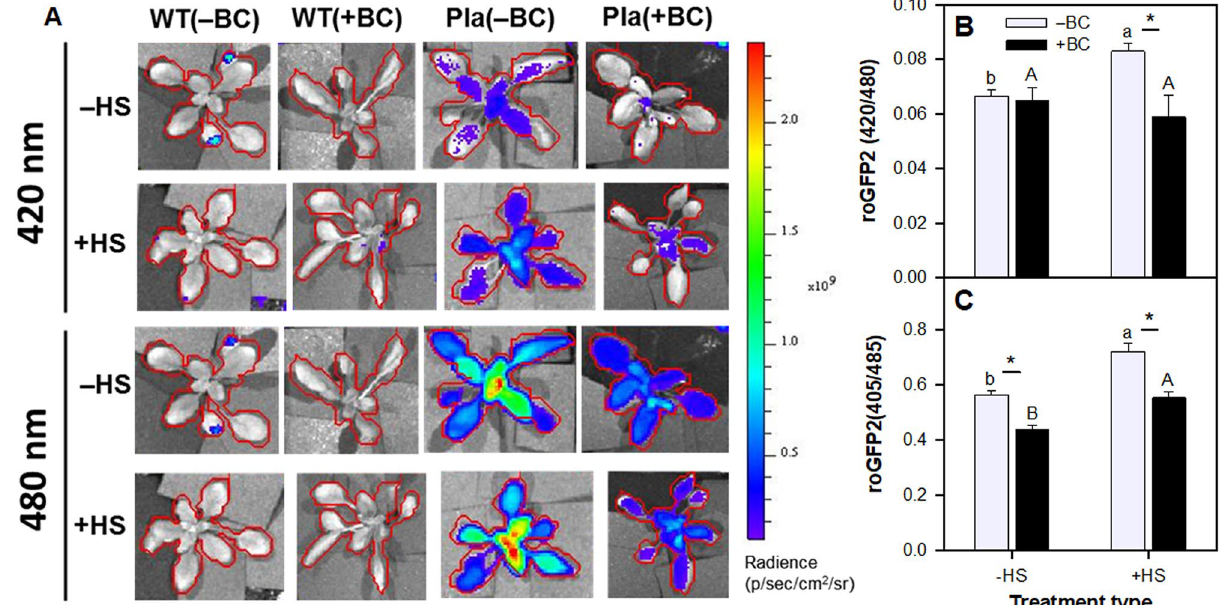
Figure 3. Effect of absence ( ‒ BC) and presence (+ BC) of biochar on the redox level of wild type (WT) plants and Arabidopsis thaliana expressing roGFP2 in the plastids (pla-roGFP2) under ‒ HS and + HS conditions at 21 days. ( A ) In-vivo qualitative depiction of whole WT and roGFP2 plants excited at 420 nm (oxidation) and 480 nm (reduction); ( B ) In-vivo redox (oxidized/reduced) state of roGFP2 plants calculated after subtracting WT values from respective roGFP2 plants; ( C ) In-vitro redox (oxidized at 405 nm /reduced at 485 nm) state of roGFP2 plants analyzed using leaf discs and calculated after subtracting WT values from respective roGFP2 plants. Data represents three combined separate experiments. Columns (n = 9; means ± S.E.) labeled by different lowercase and uppercase letters are significantly ( p < 0.05) different within the ‒ BC and + BC groups and in ‒ HS and + HS treatments, respectively. Asterisk denotes significant difference at p ≤ 0.05 according to Tukey Kramer HSD test between –BC and + BC at a given heat